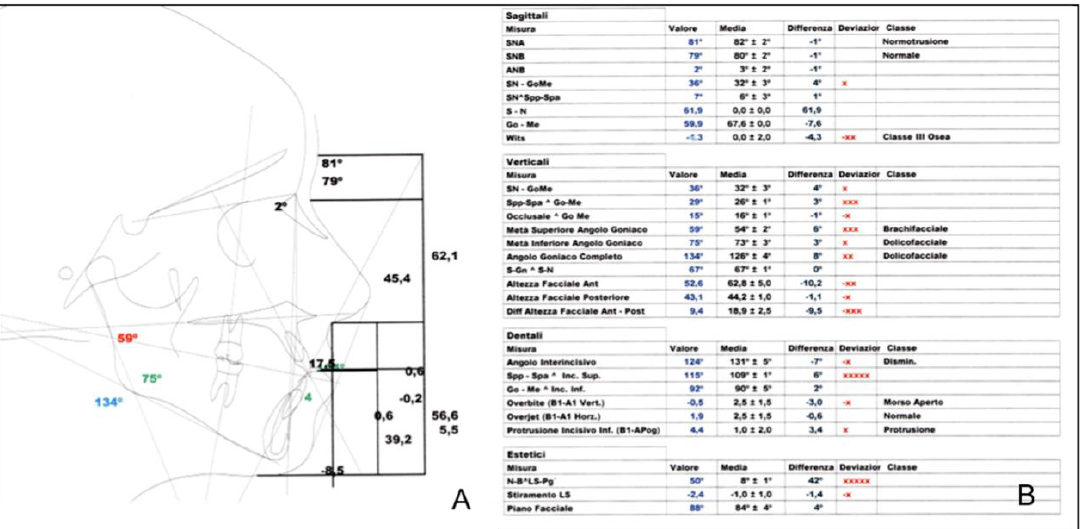
Figure 12. Final cephalometric tracing ( A ) and analysis ( B ).